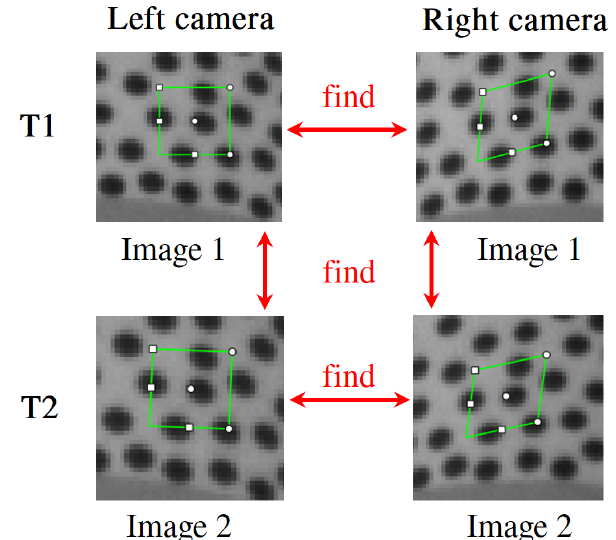
Figure 5. The DIC algorithm finds points by tracking the greyscale signature of the subset in every picture.